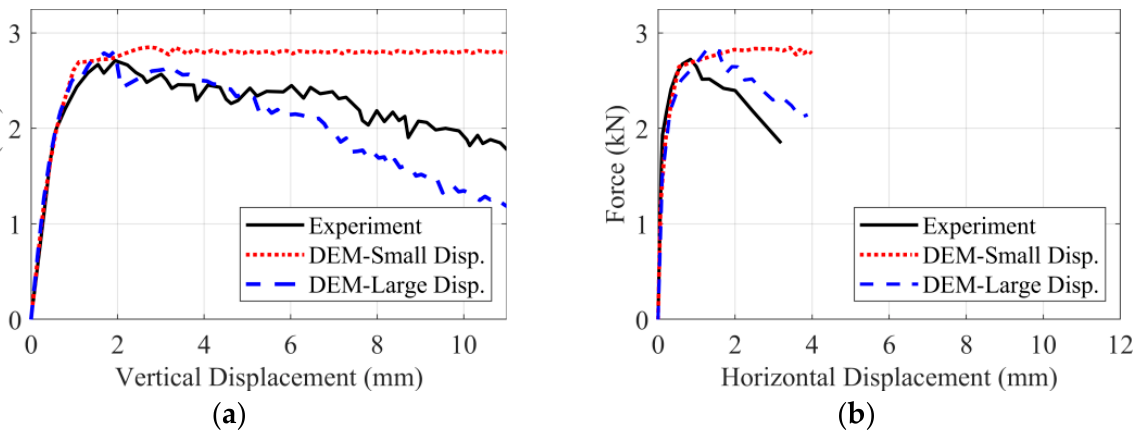
Figure 4. Load–displacement curves of experiment and DEM model for small and large displace- ments: ( a ) vertical displacement, ( b ) horizontal displacement, reproduced from [32].